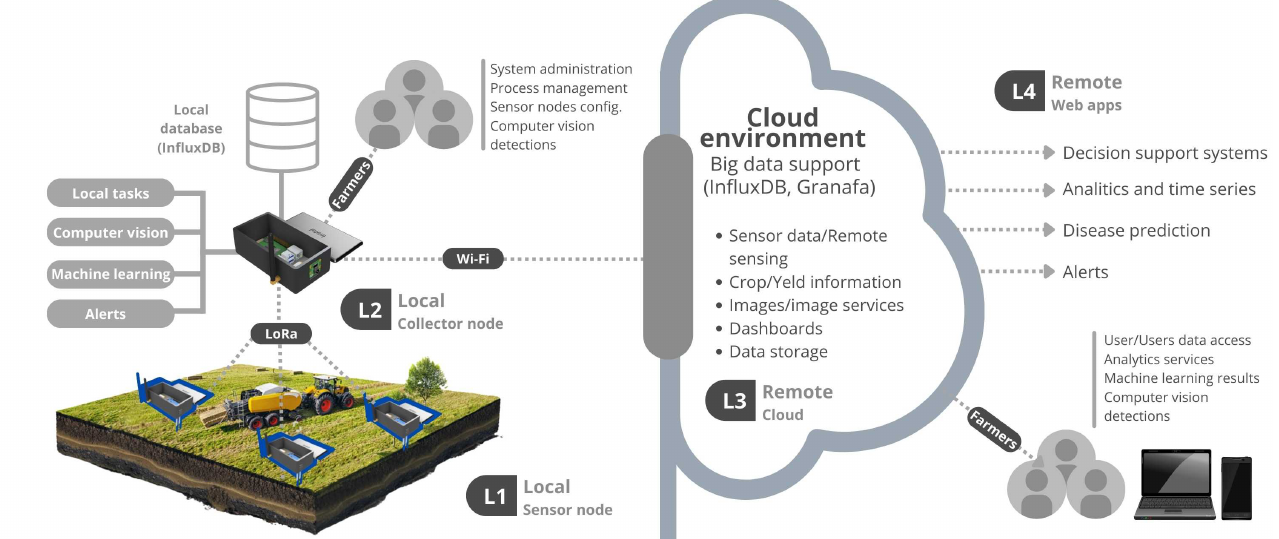
Figure 1. Overall IoT system